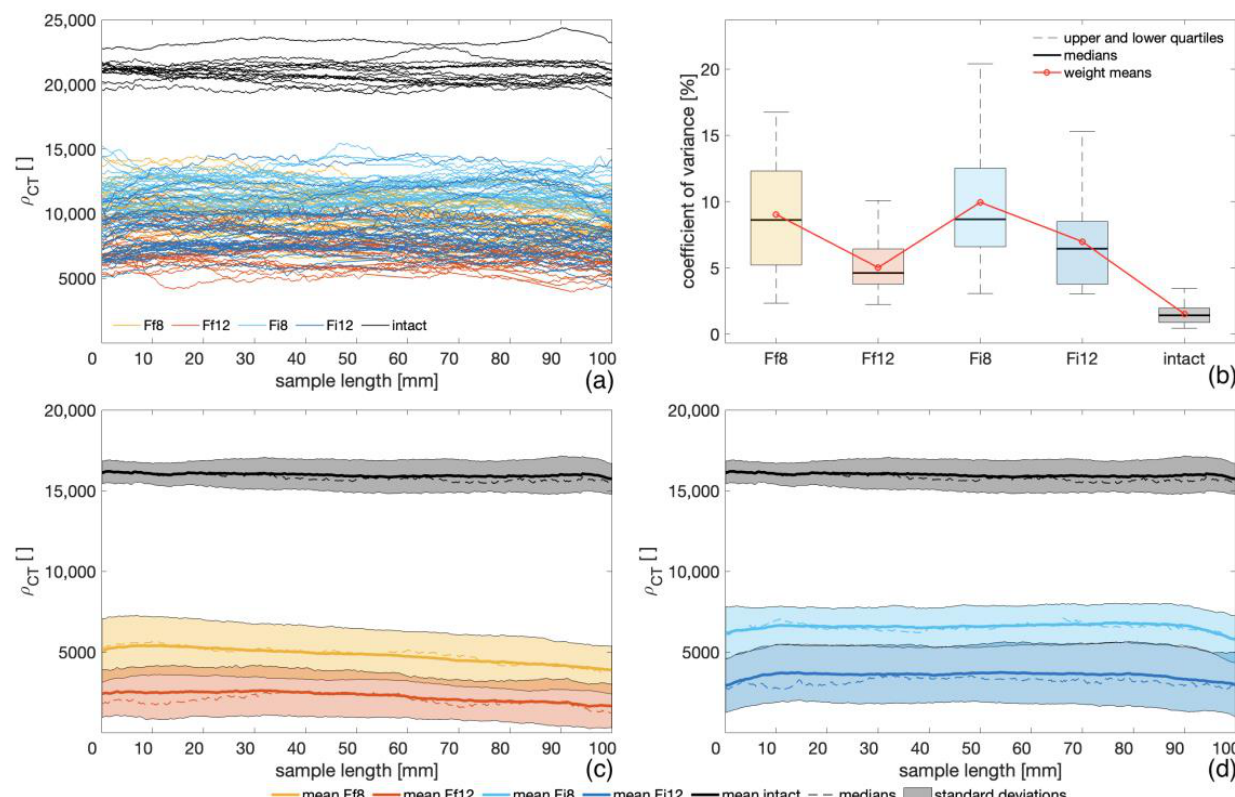
Figure 4. Density profile of all CT-scanned bending samples ( a ); variability in density distribution for each group of these samples ( b ); average values of density distribution with their standard deviations for intact samples and degraded specimens after 8 and 12 weeks of exposure to F. fomentarius ( c ) and F. inzengae ( d )